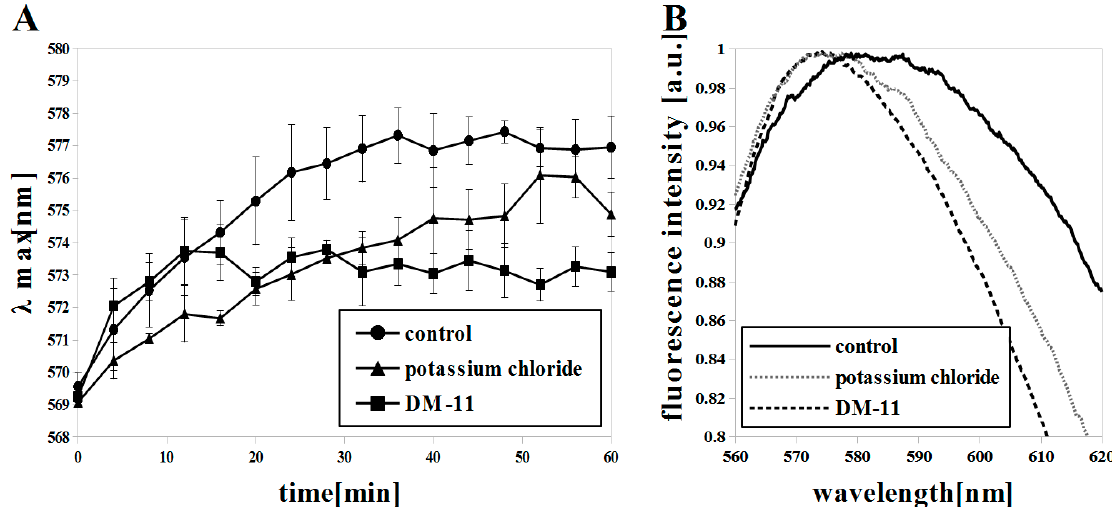
Figure 2. Plasma membrane potential ( ∆ ψ ) reduction and membrane depolarization in C. albicans induced by KCl (200 mM) and DM-11 (50 µ M) in early log phase (8 h) shown by: ( A ) diS-C 3 (3), means ± SD (n = 4) and ( B ) di-4-ANEPPS (R-B values = 1.040 ± 0.025, 0.991 ± 0.002 and 0.978 ± 0.010 for control, KCl, DM-11, respectively), each spectrum is averaged (n = 9).